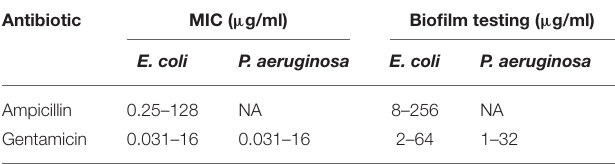
Antibiotic MIC ( µ g/ml) Biofilm testing ( µ g/ml)